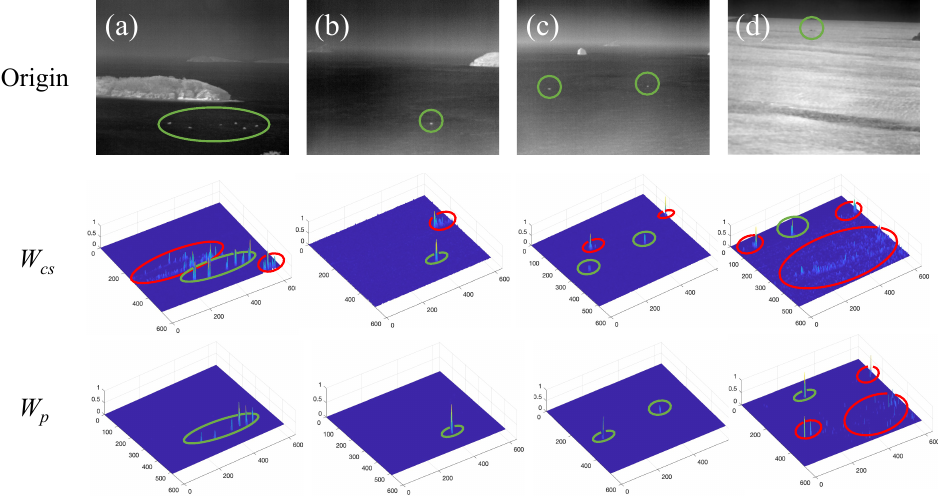
Figure 1. Corner strength maps W sc and the proposed improved method W p of four typical strong edge scenes. ( a – d ) represent four different scenes with strong edge interference,